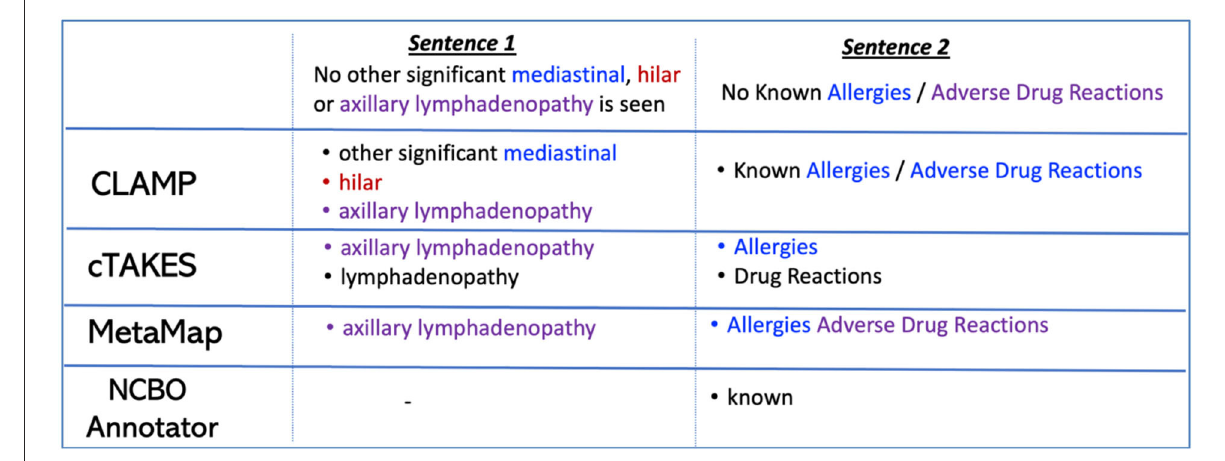
FIGURE2 Example of negated concept extraction with four concept recognition systems.